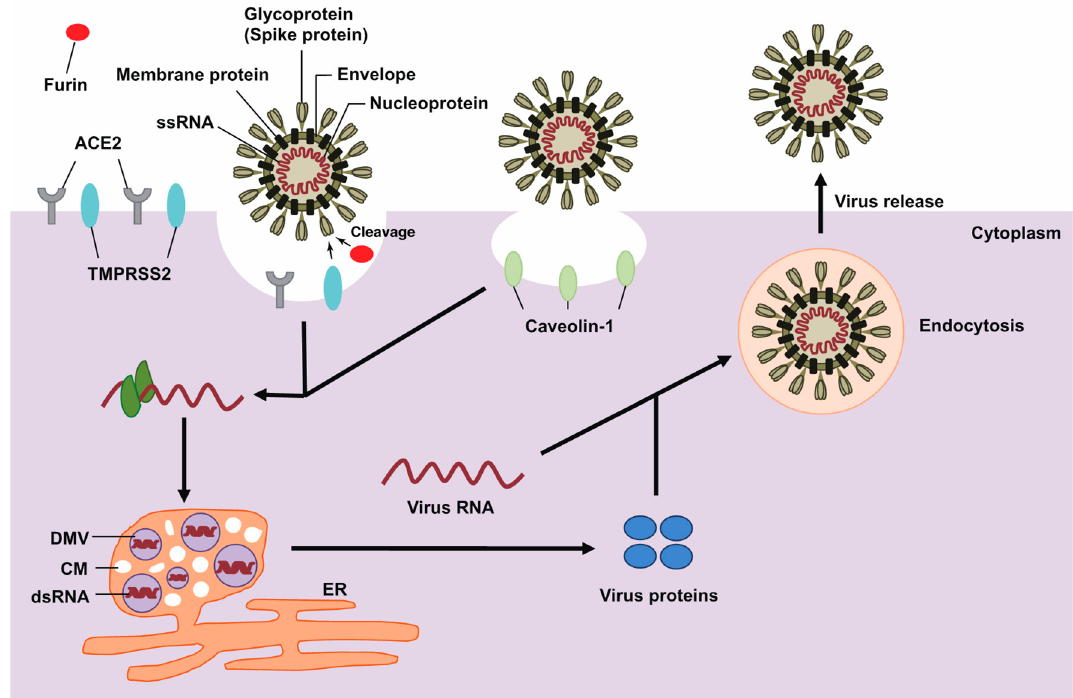
Figure 1. A schematic representation of the life cycle of coronavirus. Coronavirus spike protein (trimers) binds with membrane surface proteins of host cells to facilitate viral entry. Uncoated genomic RNA is then translated, and viral components are replicated. Viral proteins are assembled for maturation, and the newly packaged viral particles are released.